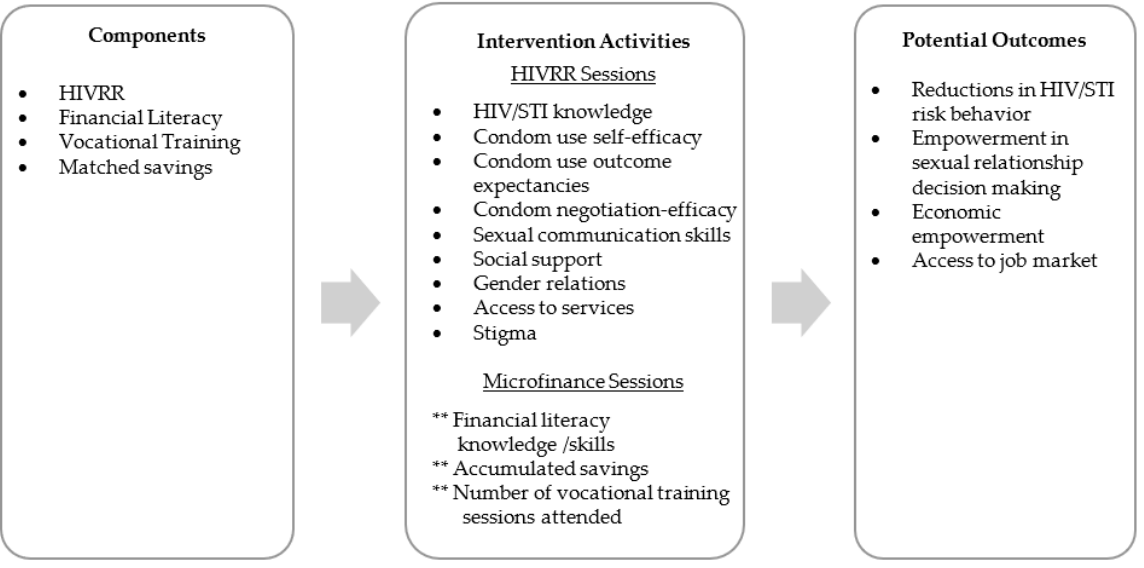
Figure 1. Conceptual model illustrating combination HIVRR and microfinance intervention. ** Uniquely associated with asset theory.